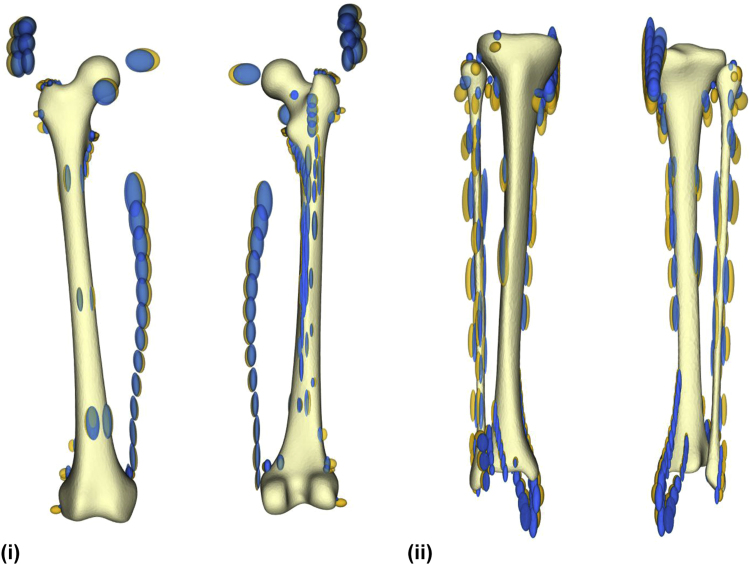
Variance of muscle attachment and via points scaled to the mean shape of (i) thigh and (ii) the shank for linear (yellow) and non-linear scaling (blue). Variances in all three coordinate axes are represented as ellipsoids with axes length scaled with the standard deviation. (For interpretation of the references to color in this figure legend, the reader is referred to the web version of this article.)